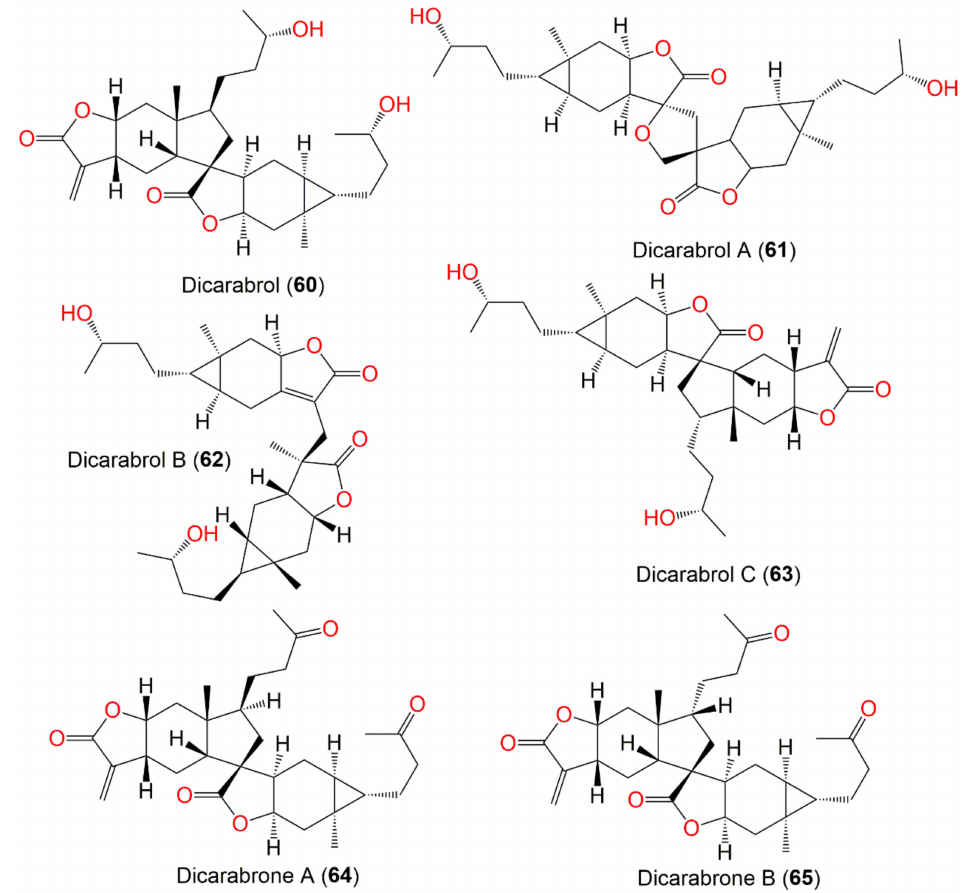
Figure 10. Dimeric sesquiterpenes ( 60 – 65 ) reported from C. abrotanoides . The investigation of the whole plant’s 95% EtOH extract afforded rare dimeric sesquiter- penes, dicarabrol A ( 61 ), dicarabrone C ( 66 ), and dipulchellin A ( 74 ). Compounds 61 and 66 featured an unwonted skeleton with two linked carabranolide moieties via a spiro- tetrahydrofuran ring that was assumed to be generated by a [4+2] cycloaddition; how- ever, 74 is a product of [3+2] cycloaddition of a carabranolide moiety and guaianolide moiety connecting via a cyclopentane ring. Their configurations were established as 1S/5S/7S/8R/10R/11S/1 (cid:48) S/5 (cid:48) S/7 (cid:48) R/8 (cid:48) R/10 (cid:48) R/11 (cid:48) R for 61 and 66 and 1S/4S/5S/7R/8S/ 10R/11S/1 (cid:48) R/4 (cid:48) S/5 (cid:48) R/7 (cid:48) R/8 (cid:48) R/10 (cid:48) R for 74 . These metabolites revealed selective cytotoxic potential versus HL-60 cells (IC 50 s 8.7, 8.2, and 8.9 µ M, respectively), while they had no activity versus A549 cells (IC 50 > 10 µ M) in the MTT assay [63]. Biosynthetically, it was proposed that [4+2] Diels–Alder cycloaddition is the main step for 61 and 66 biosyntheses (Scheme 6). Carabrone ( 55 ) and carabrol ( 56 ) could be the parent compounds for their biosynthesis. The double bond (C11 (cid:48) =C13 (cid:48) ) of one carabrone/carabrol undergoes [4+2] Diels–Alder cycloaddition with the α , β -unsaturated carbonyl (C13=C11–C12=O) of an- other carabrone ( 55 )/carabrol ( 56 ) to yield an intermediate I with a dihydropyran ring. Then, the enzymatic oxygenation of the dihydropyran double bond produces an oxirane ring in II. Lastly, two C–O bonds displace each other to form the tetrahydrofuran ring in dicarabrone C ( 66 )/dicarabrol A ( 61 )